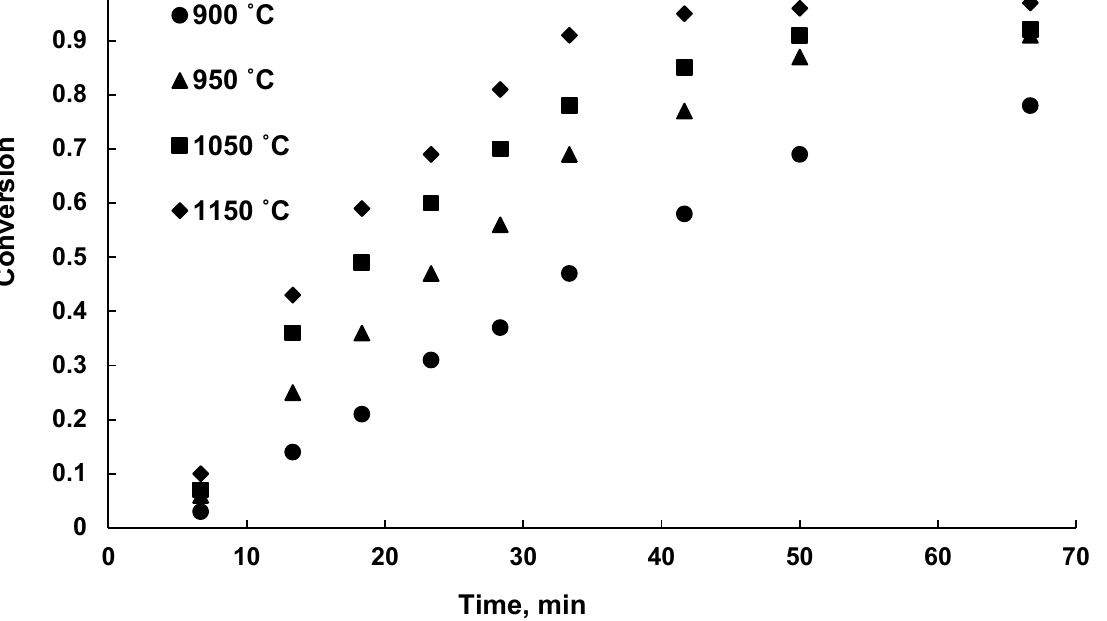
Figure 7. Conversion-time plots for the reduction of barite compacted samples (zone B; see Figure 1) with brown coal.